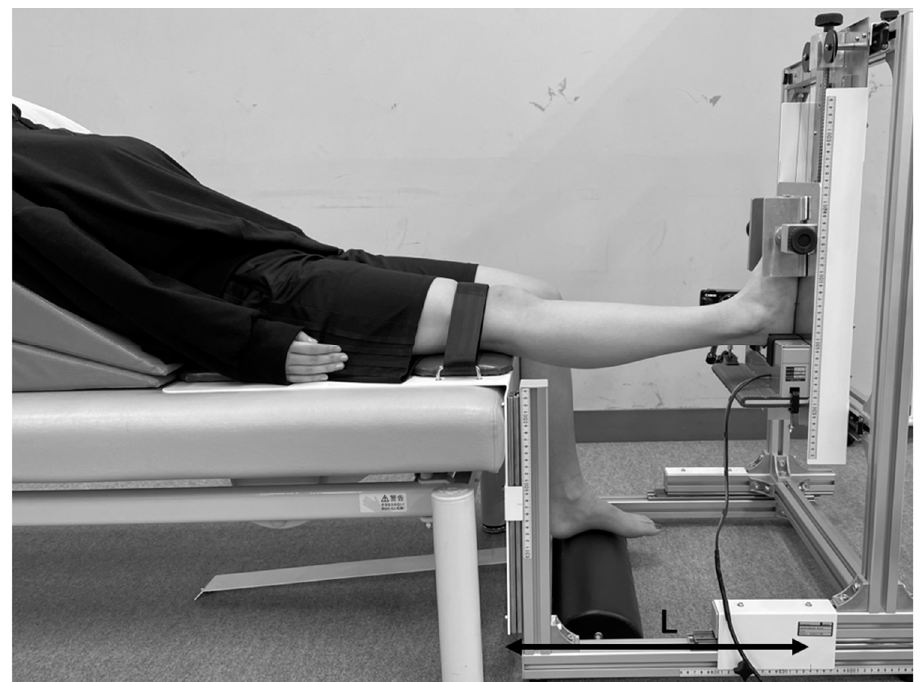
Figure 1. Position for measurement of genu recurvatum. The subject sat on the hyperextension apparatus in a relaxed position on the backrest cushion. Hip flexion was approximately 50 ◦ and the upper limbs were kept at the sides of the body. Length from the center of the knee to heel (L) and foot elevation values (H) were recorded. Maximum passive extension angle of the knee joint was later calculated.